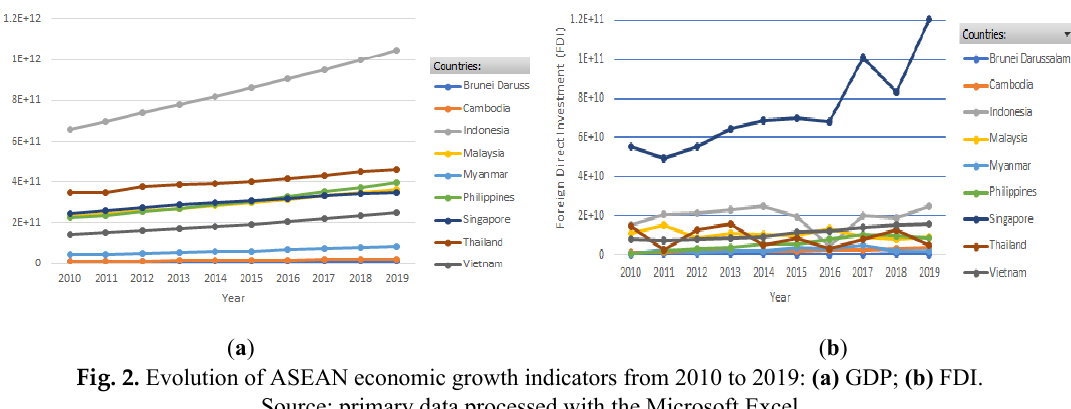
Fig. 2. Evolution of ASEAN economic growth indicators from 2010 to 2019: (a) GDP; (b) FDI. Source: primary data processed with the Microsoft Excel .